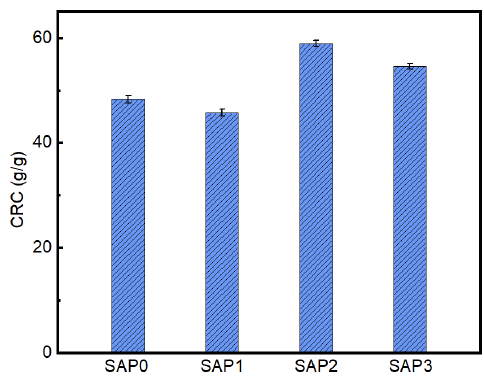
Figure 8. CRC of SAP0, SAP1, SAP2, and SAP3.